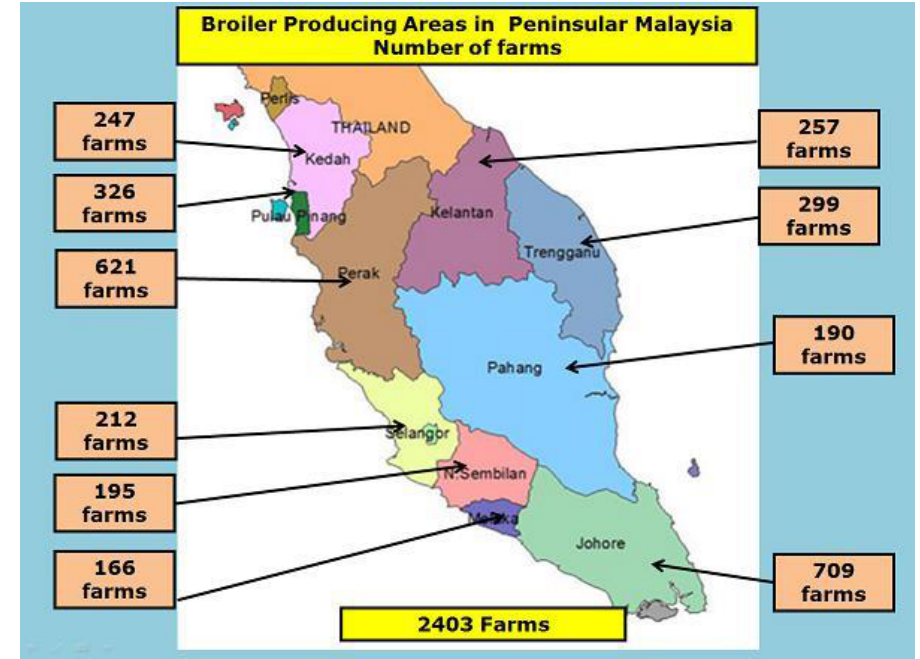
Figure 2: Total commercial broiler farm in Peninsular Malaysia (Department Veterinary Services, 2017)